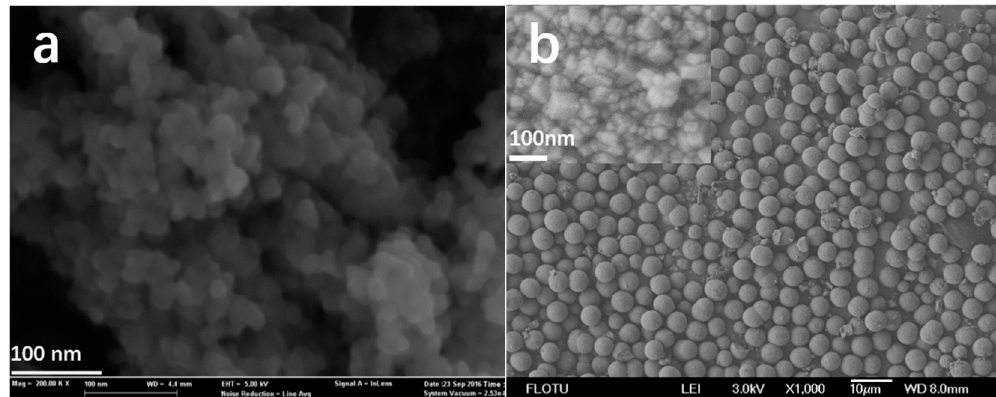
Figure 1. SEM images of the precipitates ( a ) before and ( b ) after hydrothermal treatment. The ratio of starting material, R M = 1:1:1 ( Ni:Co:Mn ) ; the total concentration of metals, C M = 0.15 mol·L − 1 ; the concentration of ammonia carbonate, C (NH4 ) 2CO3 = 0.15 mol·L − 1 ; and the temperature of hydrothermal treatment, T h = 180 °C; t h = 24 h.